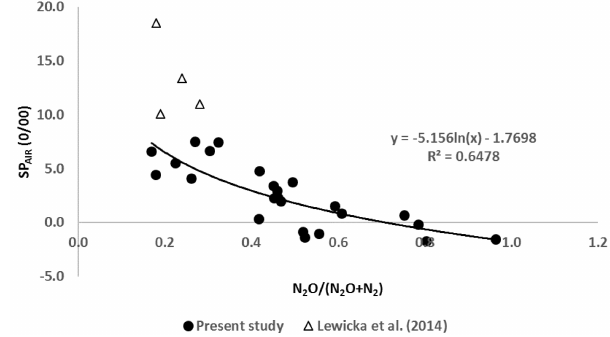
Figure 3. Ratio N 2 O / (N 2 O + N 2 ) vs. site preference (SP) for all for treatments in the first 2 days. A logarithmic function was fitted through the data; the corresponding equation and correlation coeffi- cient are given. Also shown data from Lewicka et al.